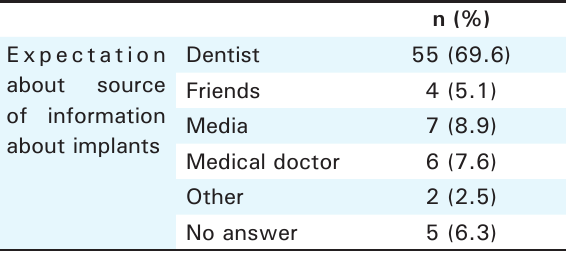
Table 6. Questions on expectations about the source of information.